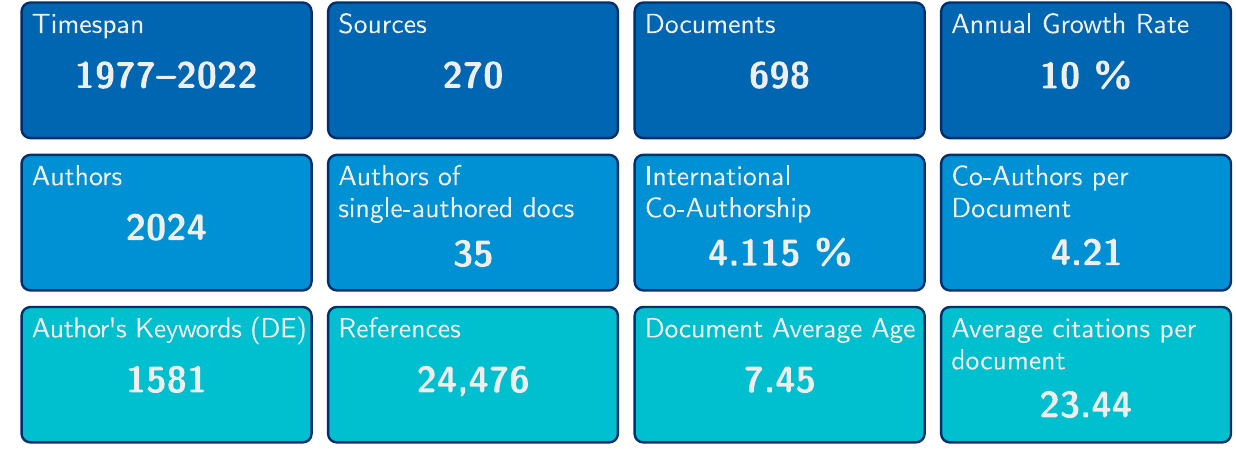
Figure 4. Main information about retrieved documents.